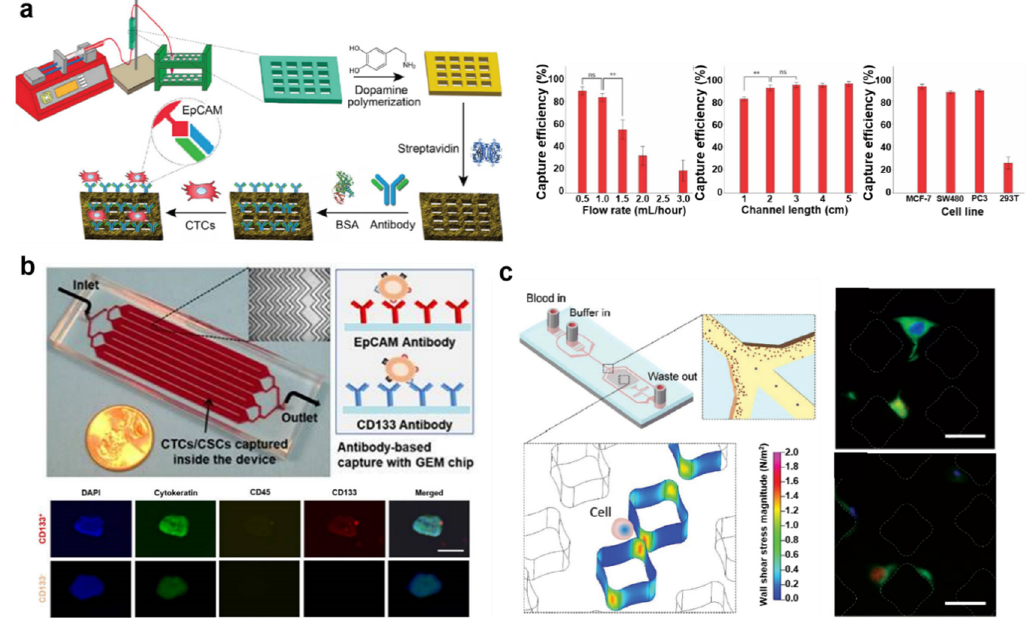
Figure 2. ( a ) Schematic images of the fabrication process of 3D-printed microfluidic device for CTC isolation; capture efficiency of CTCs under different conditions is quantified. This figure is reproduced from [45] (© 2019 Elsevier B.V.); ( b ) Schematic image of the geometrically enhanced mixing microfluidic chip for CTC and circulating cancer stem cell (CCSC) counting. This figure is reproduced from [46] (© 2019 Ivyspring International Publisher); ( c ) Schematic images of size-based CTC separation using microfluidic chip and growth of separated CTCs from blood on the microfluidic chip. This figure is reproduced from [50] (© 2020 The Royal Society of Chemistry).